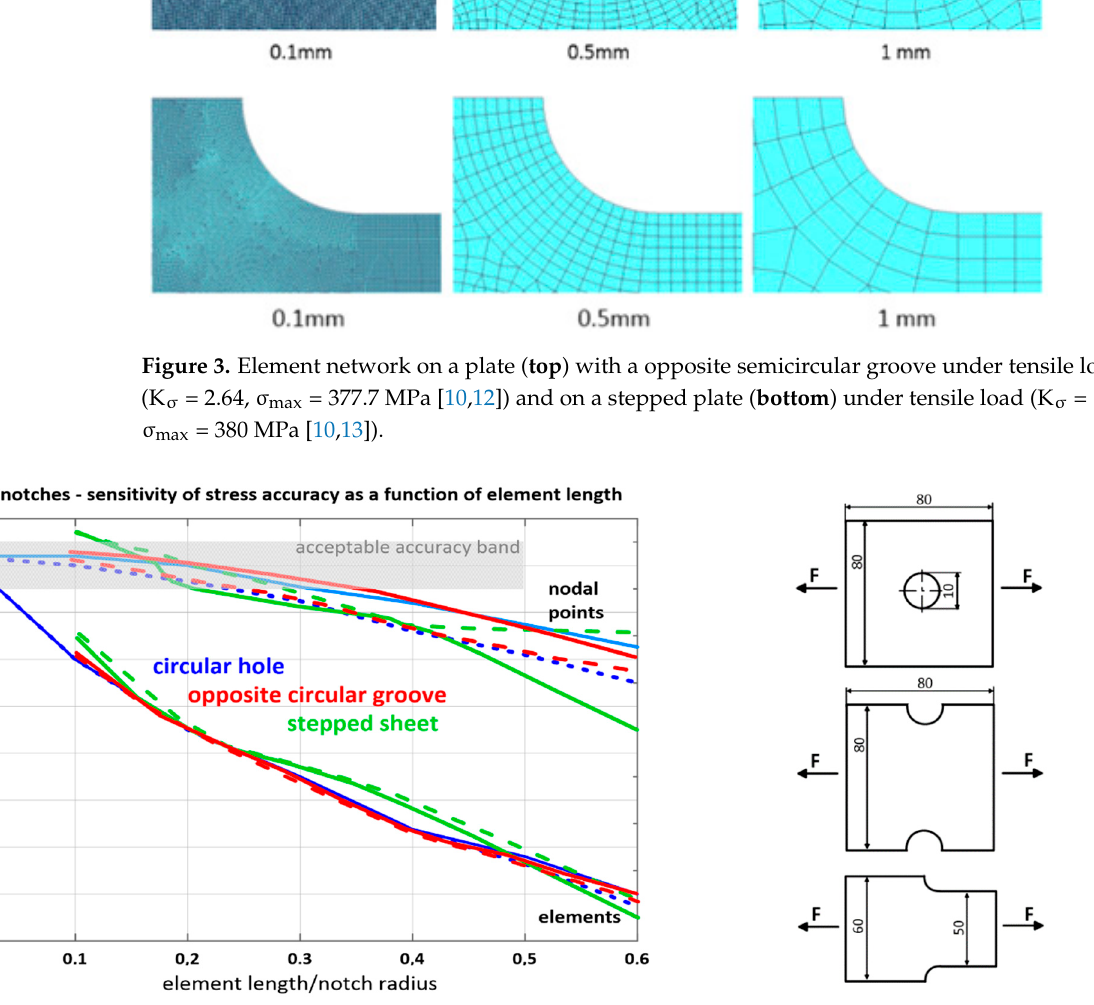
Figure 3. Element network on a plate ( top ) with a opposite semicircular groove under tensile load (K σ = 2.64, σ max = 377.7 MPa [10,12]) and on a stepped plate ( bottom ) under tensile load (K σ = 1.9, σ max = 380 MPa [10,13]).